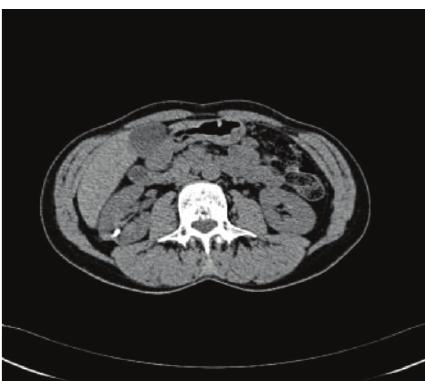
Figure 1: CT scan. Right calyx stone.